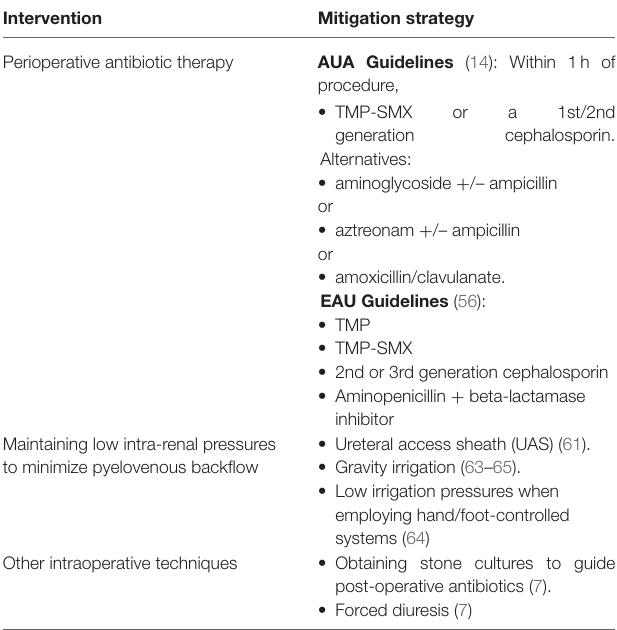
TABLE 2 | Summary of intra-operative